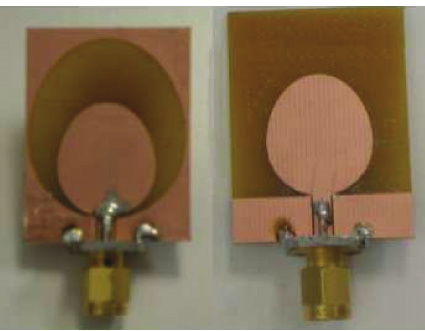
Figure 3: Two UWB antennas with optimized ground planes [43]. One has a partial ground plane and the other has a ground plane with a large